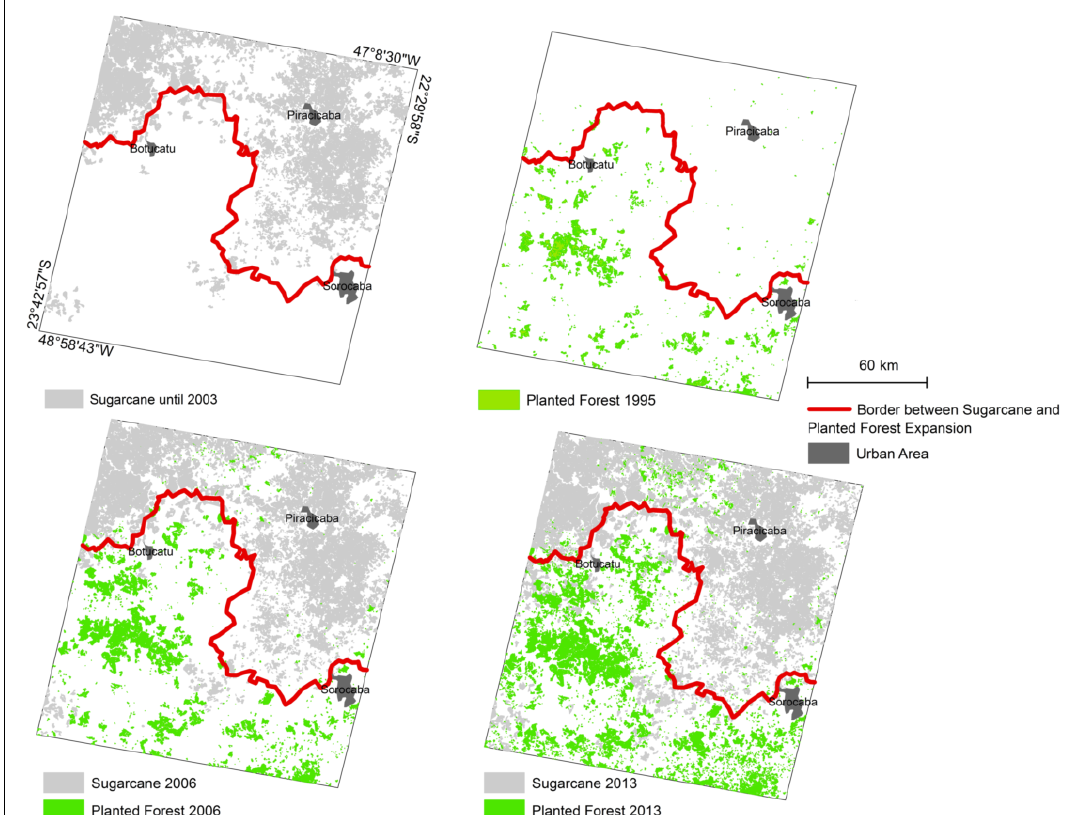
Figure 6. Areas of sugarcane (based on CANASAT [53]) and planted forest expansion (mapped in this work) over the study area during the period analyzed.